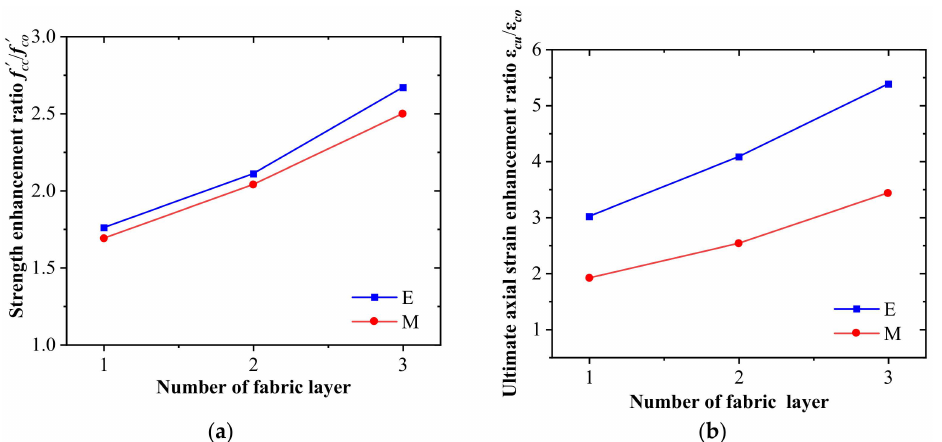
Figure 7. The influence of the number of fabric layers on the ( a ) strength enhancement rate ( f (cid:48) cc f (cid:48) co ) and ( b ) strain enhancement rate ( ε cu / ε co